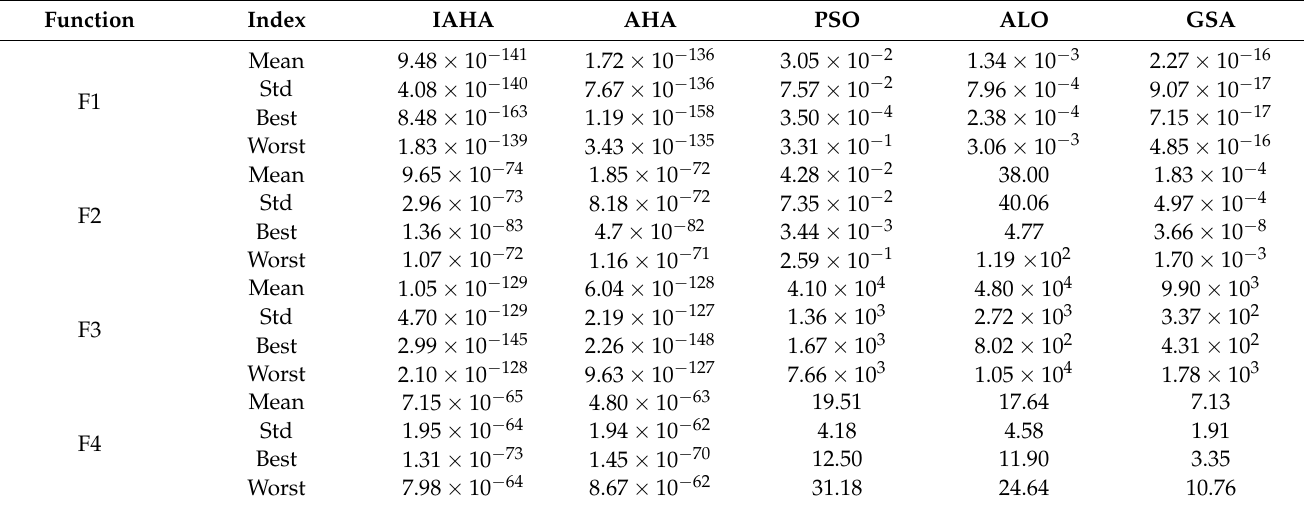
Figure 2. The average convergence curve of different optimization algorithms on a unimodal test func- tion. Table 2. Statistical results of unimodal test functions for each